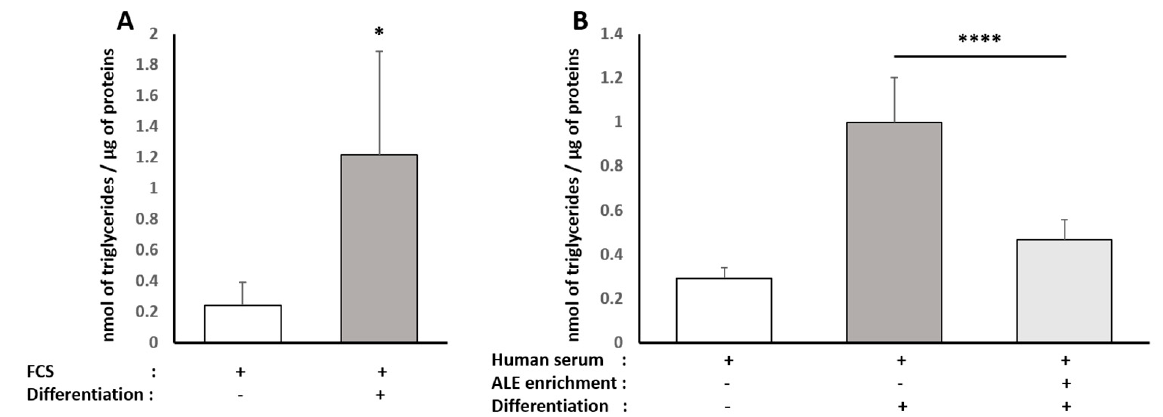
Figure 9. Effect of human serum enriched with ALE metabolites on triglyceride levels in primary human subcutaneous pre-adipocytes: Primary human subcutaneous pre-adipocytes were differentiated for 8 days in an adipocyte differentiation medium supplemented with either 10% fetal calf serum ( A ) or 10% human serum ( B ). Intracellular triglycerides were measured. Differentiation induces an increase in intracellular triglyceride content independently of the origin of the serum (calf or human). The human serum enriched with ALE metabolites significantly limited the intracellular triglyceride accumulation in differentiated adipocytes * ( p < 0.05); **** ( p < 0.0001).